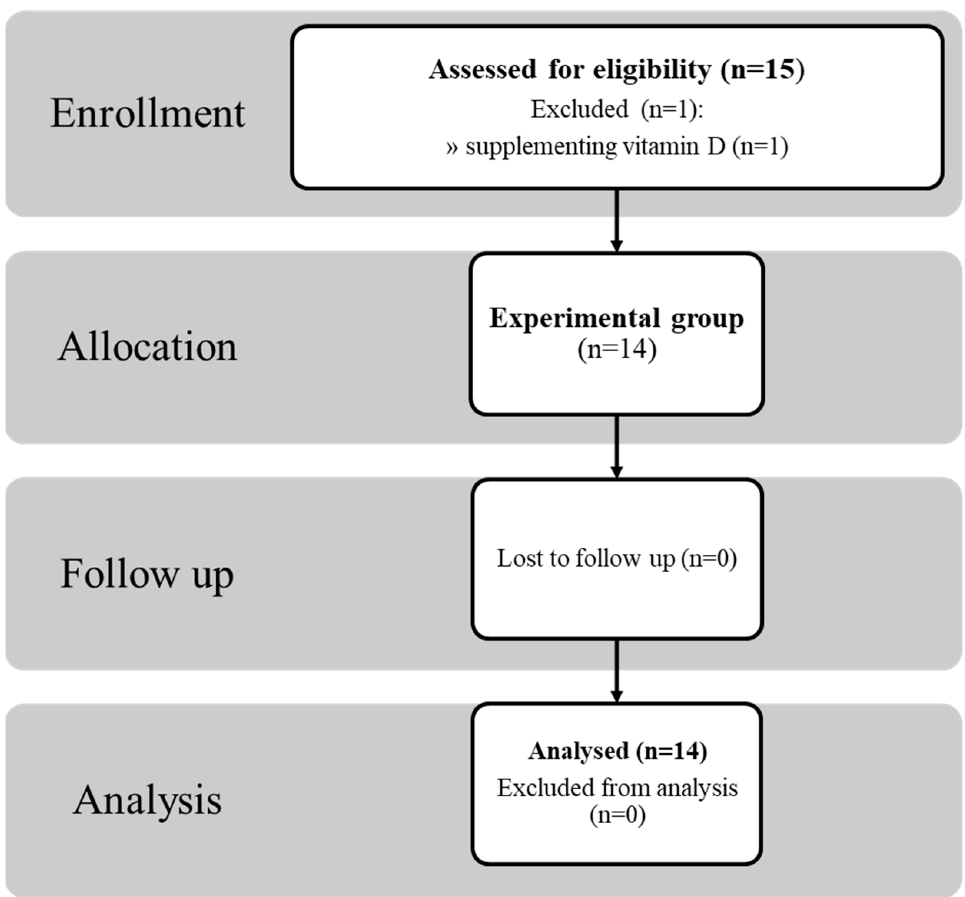
Figure 1. Flow diagram of participant progress through the phases of the study.